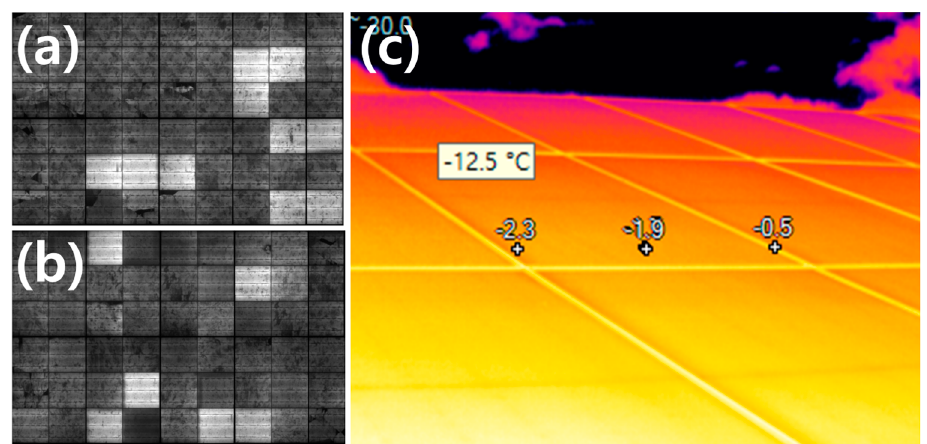
Figure 12. I mages of the recovered module (190 A, 190 B). ( a ) is an EL image of the repaired 190A module, and ( b ) is an EL image of the repaired 190B module. ( c ) is an IR image of 190A and 190B re-installed at the plant.